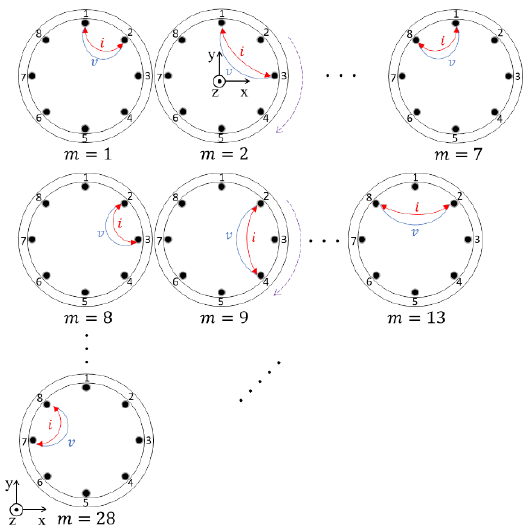
Figure 5. Kelvin-clip measurement patterns.